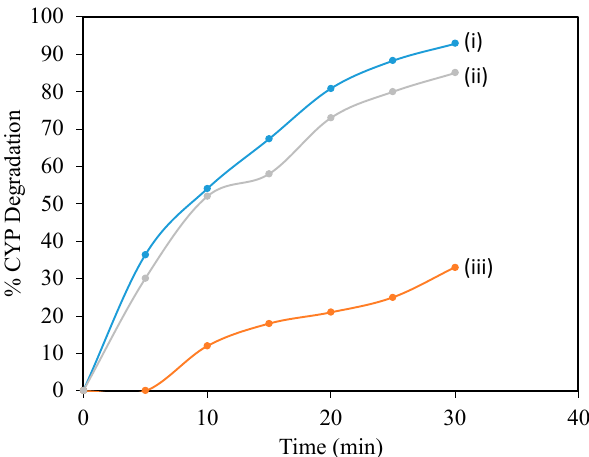
Figure 4. Effect of scavengers on degradation of CYP by Mg (OH) 2 /O 3 : (i) no scavenger, (ii) BZQ, (iii) t-BuOH.